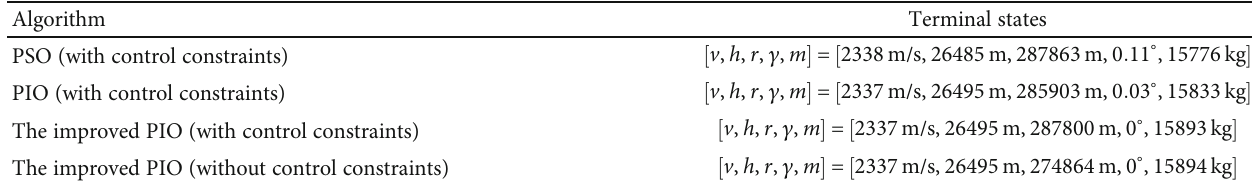
Figure 6: Dynamic pressure, heat fl ux, and overload of optimal ascent trajectories. Table 3: Terminal states of trajectories.